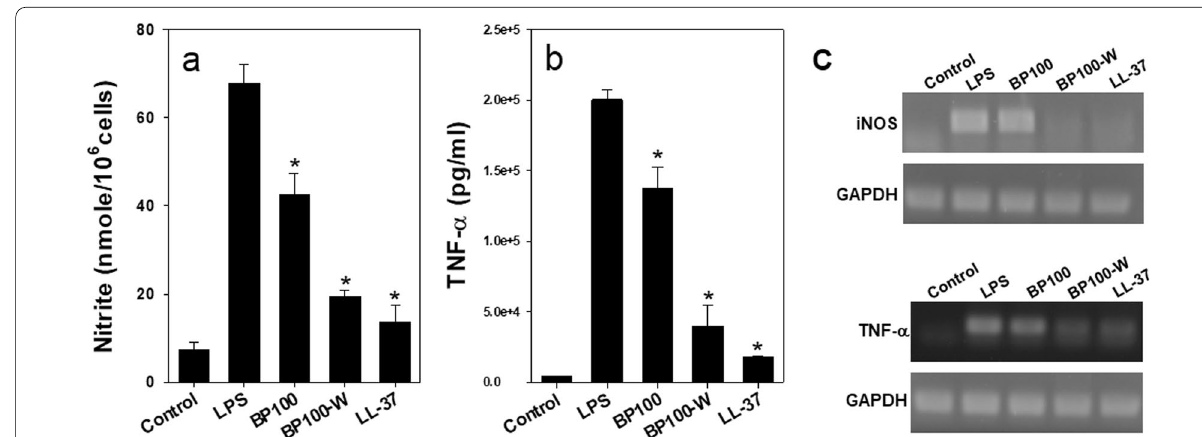
Fig. 6 a Effects of BP100 and BP100-W on nitric oxide (NO) production in lipopolysaccharide (LPS)-stimulated RAW264.7 cells. b Effects of BP100 and BP100-W on tumor necrosis factor (TNF)-α release from LPS-stimulated RAW264.7 cells. Concentration of peptides used for this experiment is 8 μM. All data represent at least three independent experiments and are expressed as the mean standard error of the mean (SEM). Data were ± analyzed using one-way analysis of variance (ANOVA) with Bonferroni’s post-test. Asterisks indicate the statistically significant differences (* P < 0.001 for each agonist). c Effects of BP100 and BP100-W on the mRNA levels of inducible nitric oxide synthase (iNOS) and TNF-α in LPS-stimulated RAW264.7 cells. RAW264.7 cells (5 10 5 cells/well) were incubated with the peptides in the presence of LPS (20 ng/mL) for 3 h (for TNF-α) or 6 h (for × iNOS). Total RNA was isolated and analyzed to determine the mRNA levels of iNOS and TNF-α using reverse transcription-polymerase chain reaction (RT-PCR). Concentration of peptides used for this experiment is 8 μM